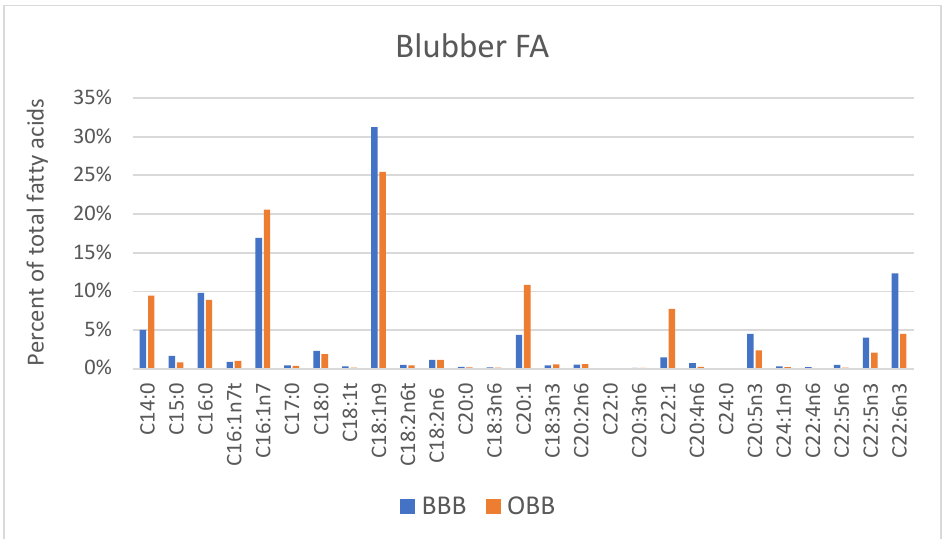
Figure 2. FA profiles for blubber are presented for Bristol Bay belugas (BBB, n = 8) versus oceanaria- based belugas (OBB, n = 4), respectively. Data expressed as percent of total FAs. FA profiles for blood and tissue components of BBB are shown in Figure 3. Mean ± SD values are provided, along with OBB values in Table S1. Whole blood FAs were identified to be an approximate average of RBC and Plasma FAs as expected since blood is an approximately 50:50 mix of these two pools.